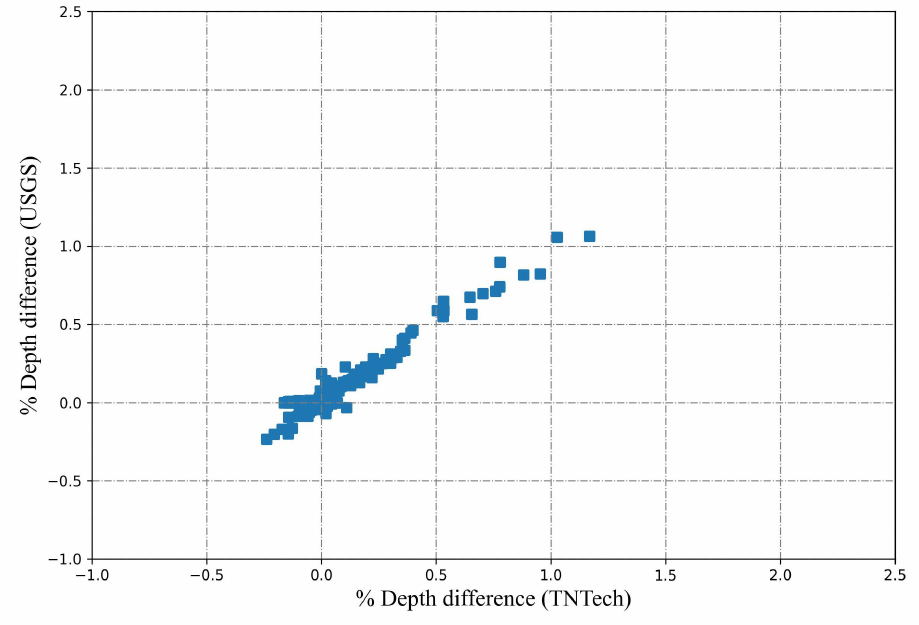
Figure 9. Percent change in the depth comparison between the